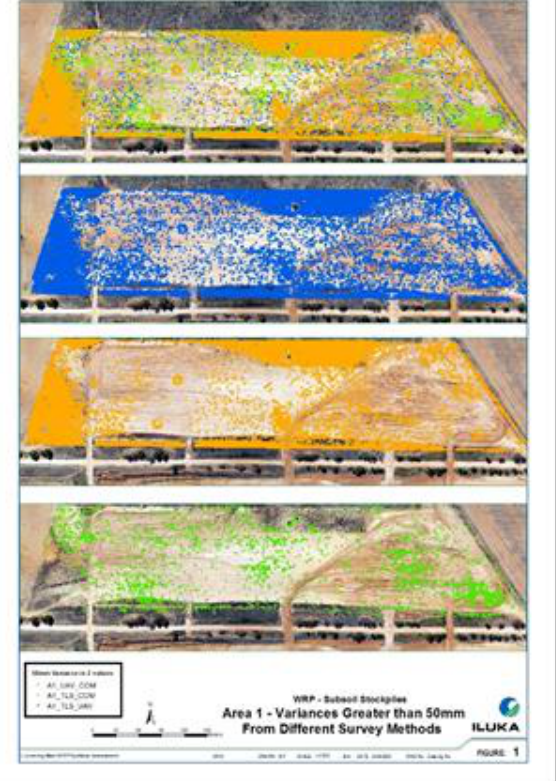
Figure 4: Map of Area 1 indicating the +/- 0.05m variations between the TLS, UAV and Combined Surface